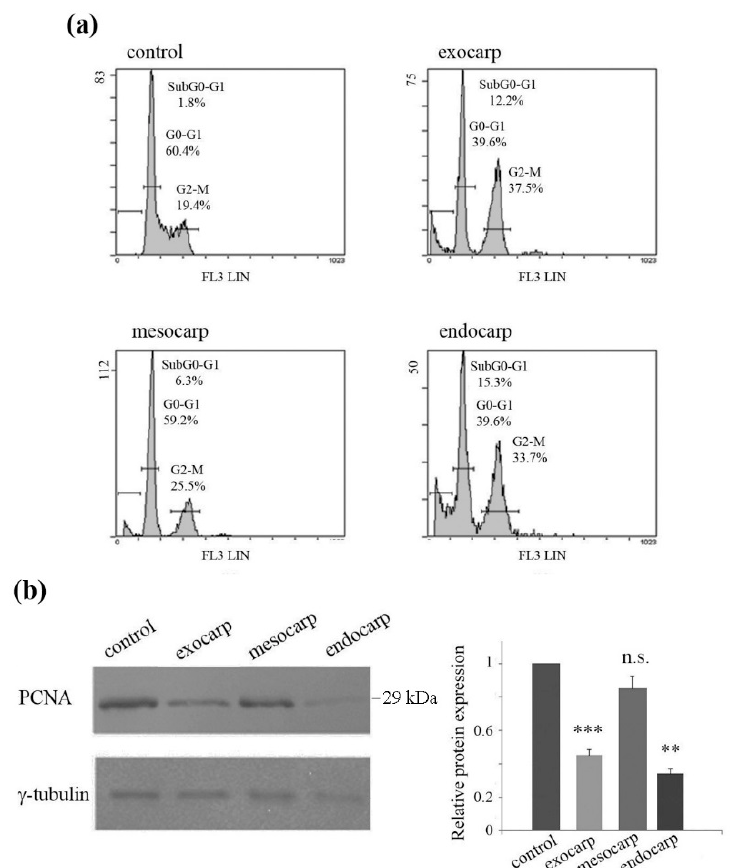
Figure 2. Effects of litchi extracts on cell cycle distribution and nuclear proliferating cell antigen (PCNA) level. ( a ) HT29 cells were exposed to 150 µg/mL gallic acid equivalents (GAE) litchi exocarp, mesocarp or endocarp treatment for 48 h, then the DNA content was evaluated by flow cytometry after staining the cells with a hypotonic propidium iodide solution. The graphs show the percentage of cells, calculated by the Expo 32 software, in the different phases of the cell cycle as described in the Materials and Methods. ( b ) Western blotting of PCNA levels after treatment with the litchi extracts. The correct protein loading was ascertained by immunoblotting for γ -tubulin. Representative blots of three independent experiments and densitometric analysis are shown. (**) p < 0.01; (***) p < 0.001 compared with control; n.s. not significant.